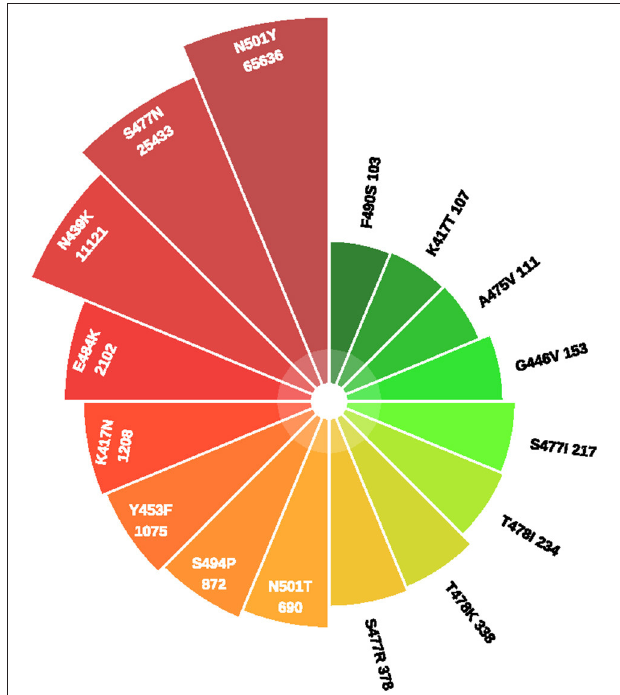
FIGURE 2 | The frequency of mutations in S